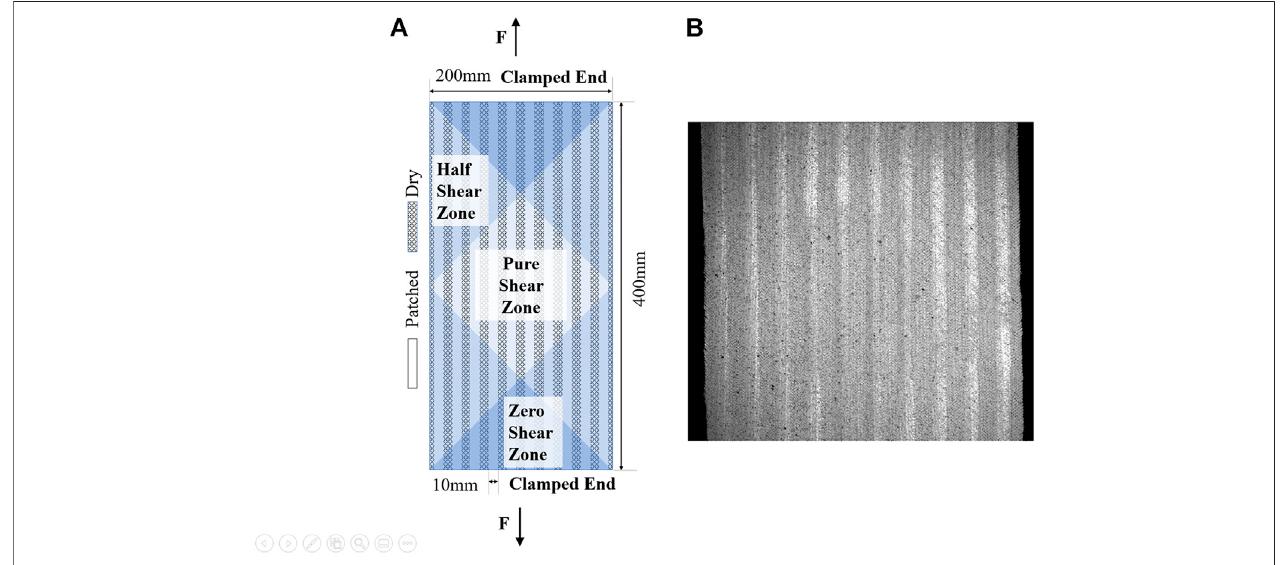
FIGURE2| Bias extension test withmodi fi edsample geometry (A) schematicdiagram ofpatch distribution; (B) actual geometry ofthe samplewith50%coverage of PLA patches (painted).